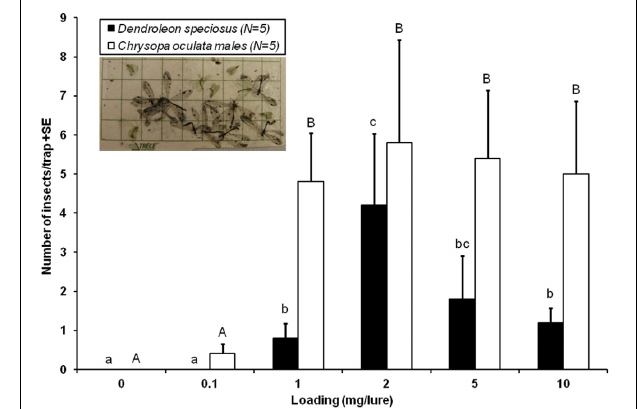
FIGURE 2 | Dose-response attraction of Dendroleon speciosus antlions and Chrysopa oculata golden-eyed lacewings to (1 R ,2 S ,5 R ,8 R )-iridodial ( N = 5; PE-bag dispensers; 1–11 August 2006, Spokane, WA, USA). Bars with the same letter within the same species were not statistically different ( P > 0.05) by the Student–Newman–Keuls all pairwise comparisons after the nonparametric Kruskal–Wallis ANOVA on rank